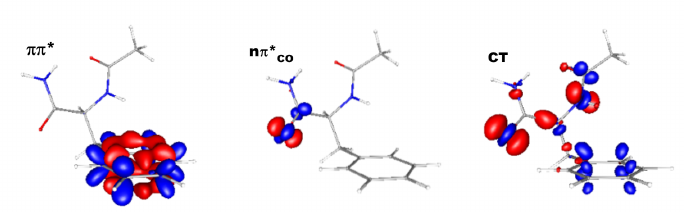
Figure 2. Contours ( ππ * ± 0.0015 au, n π * CO(2) ± 0.03 au, and CT ± 0.007 au) of the CC2 electron density difference between excited and ground states, calculated at the B97-D2/TZPP optimized geometry of the Fa B ground state. A density increase (decrease) is indicated in blue